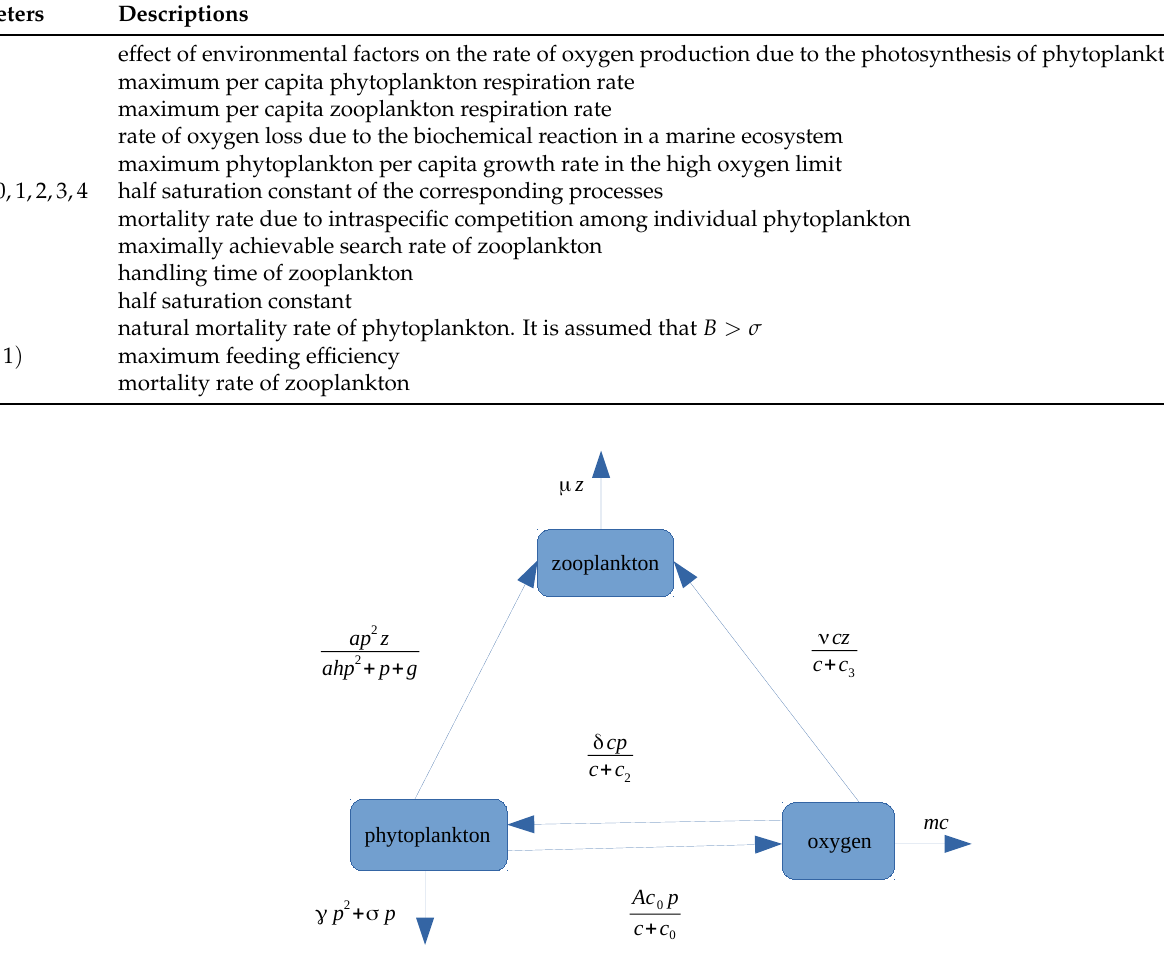
Figure 1. Graphical scheme representing the interactions among oxygen, phytoplankton, and zoo- plankton, where phytoplankton produce oxygen through photosynthetic activity in sunlight and consume it during the night for their respiration; zooplankton depend on phytoplankton for their growth and consume oxygen for their